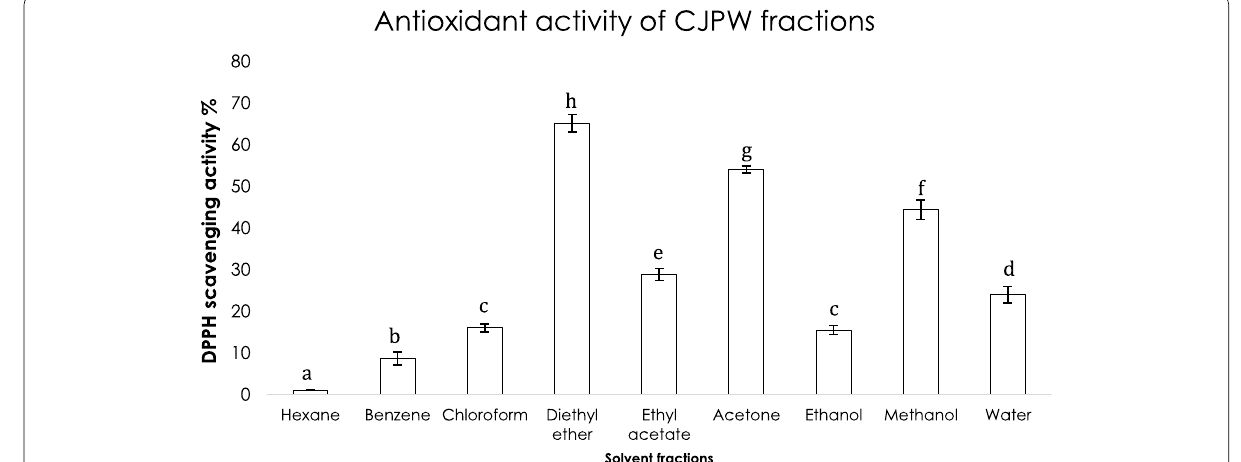
Fig. 7 Antioxidant activity (DPPH scavenging activity %) of different solvent fractions of CJPW ( Camellia japonica petal wine). Error bars represent standard deviations. Means with different lowercase superscript alphabets differ significantly ( P <